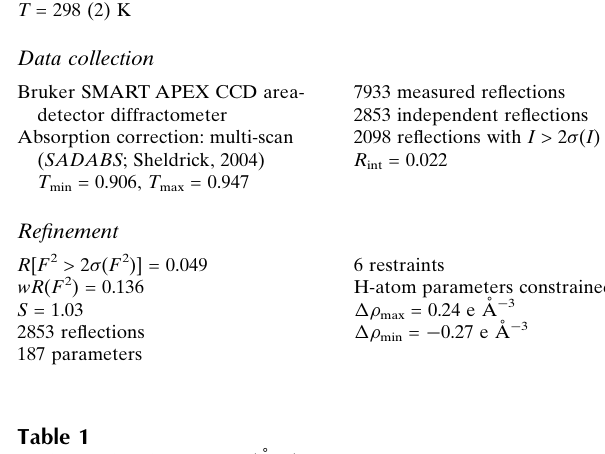
Hydrogen-bond geometry (A˚ , (cid:2)